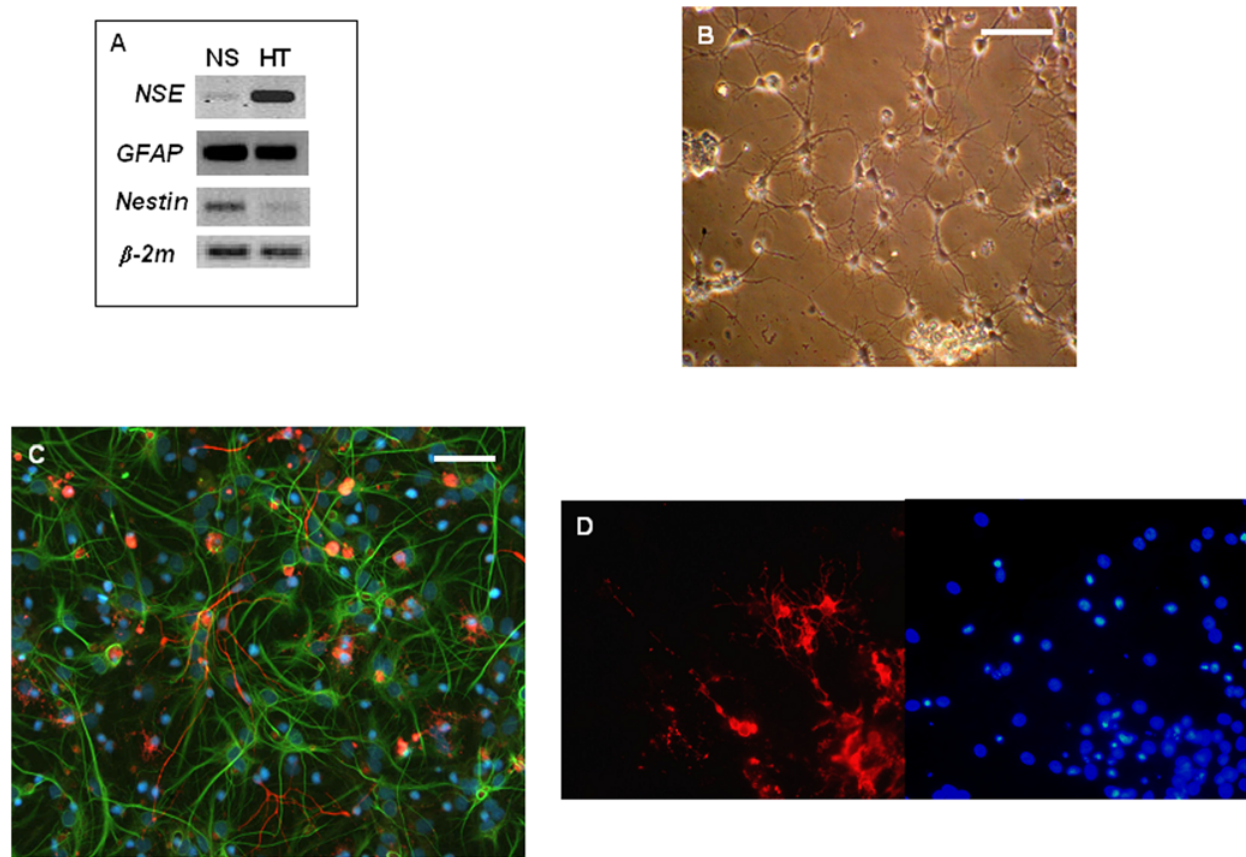
Figure 4. Hypothalamic NS cultures harbor precursors that can differentiate in neurons and glial cells. A: Gene expression analysis of some lineage-specific CNS markers by RT-PCR. RNA was isolated from hypothalamic-derived fetal secondary NS and adult hypothalami (HT) used for comparison: NSE , a marker for neurons, GFAP , a marker for astrocytes and Nestin , a marker for undifferentiated/neuroepithelial cells. b -2 microblobulin ( b -2m ) was used as housekeeping gene. B: Phase-contrast image showing the typical morphology of differentiating NS cultures after 7DIV. C: Representative fluorescence micrograph after double-labeling immunofluorescent detection of neuronal and astrocyte cells in fetal differentiating cultures (7DIV) by using antibody lineage-specific markers: b TubIII (red: neurons) and GFAP (green: astrocytes). Nuclei are stained in blue by the dye DAPI. D, fluorescence micrograph after immunofluorescent detection of oligodendrocyte cells (showned here in red) in fetal differentiating cultures (7DIV) by using an antibody oligodendrocyte-specific marker: O4 (left side). DAPI-stained nuclei from same micrograph shown on right side. Scale bars: 50 m m.